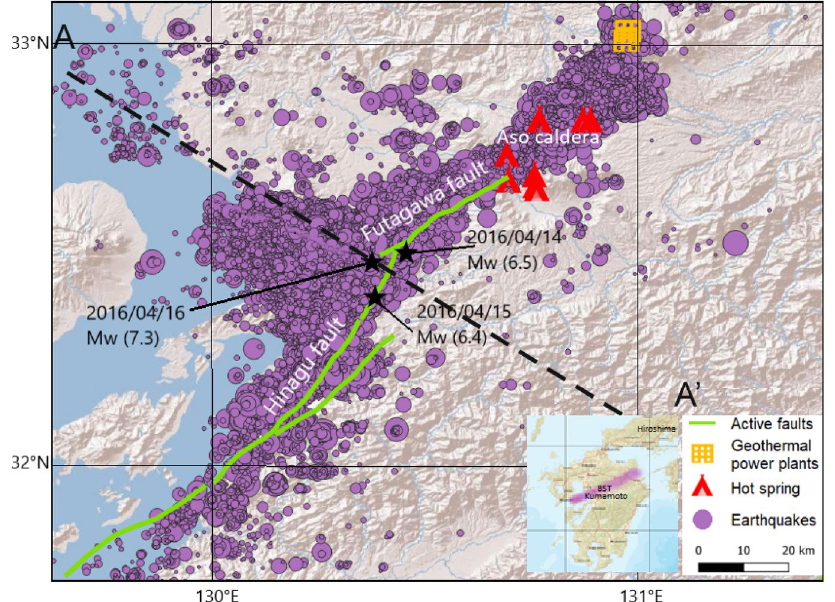
Figure 1. Digital elevation model of the study area, including hypocenters (purple dots) of 50.406 aftershocks from the Kumamoto earthquake sequence 2016 in southern Japan. Circle sizes refers to the earthquake magnitude, the black stars show the three main earthquakes, the green line shows the fault direction, and the red symbols show the hot volcanic springs of the Aso caldera and yellow boxed indicate the geothermal power plants (Hatchōbaru and Otake). The Beppu–Shimabara Trench (BST) is shown in purple in the subfigure. Figure generated with QGIS 3.16.15 Geographic Information System, http:// qgis. osgeo.